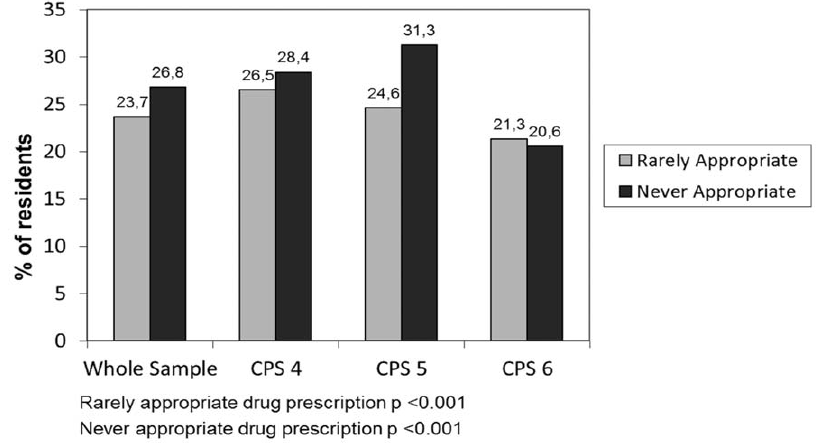
Figure 1. Inappropriate drug use according to Cognitive Performance Scale (CPS) score.